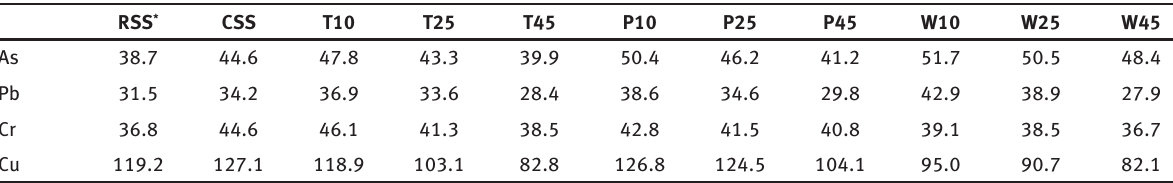
Table 5 : Total concentration (mg kg -1 ) of HMs in RSS and composted SS